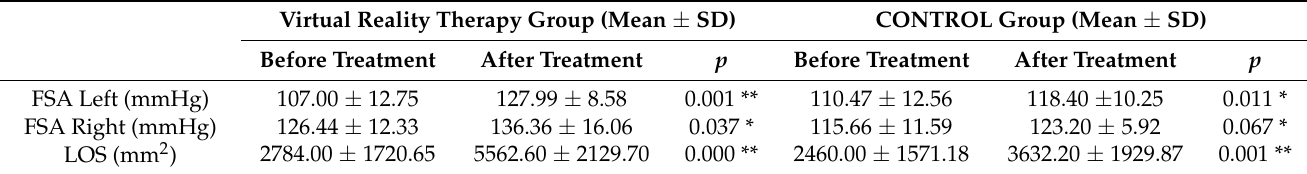
Table 3. Changes in parameters before and after treatment.